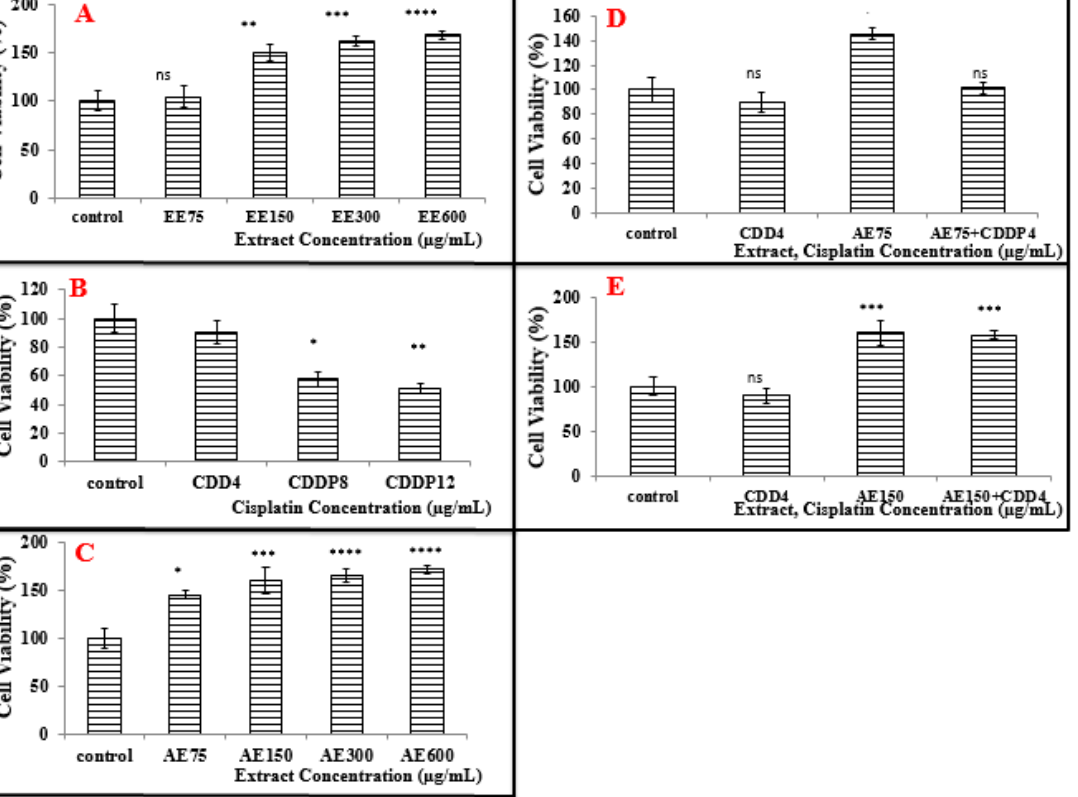
Figure 6. Cell viability of peripheral blood mononuclear cells (PBMC) after treatment for 24 h. ( A ) Cell viability of PBMC cells after treatment with the ethanolic extract of E. camaldulensis for 24 h. ( B ) Cell viability of PBMC cells after treatment with increasing concentrations of CDDP for 24 h. ( C ) Cell viability of PBMC cells after treatment with the aqueous extract of E. camaldulensis for 24 h. ( D ) Cell viability of PBMC 24 h after treatment with CDDP (4 µ g / mL) combined with the aqueous extract (AE 75 µ g / mL). ( E ) Cell viability of PBMC 24 h after treatment with CDDP (4 µ g / mL) combined with the aqueous extract (AE 150 μ g/mL) (* p < 0.05, ** p < 0.01, *** p < 0.001, **** p < 0.001).